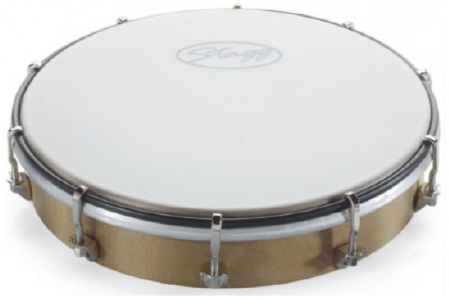
Figure 1. Measurement object.